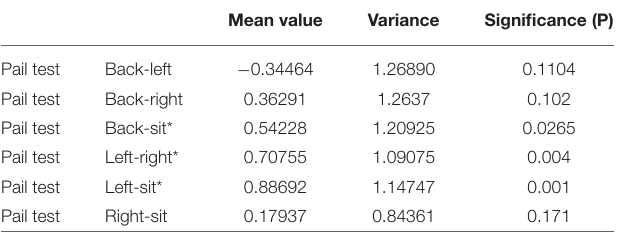
FIGURE 13 | The deviation under four postures. TABLE 2 | Paired sample test between two postures. Mean